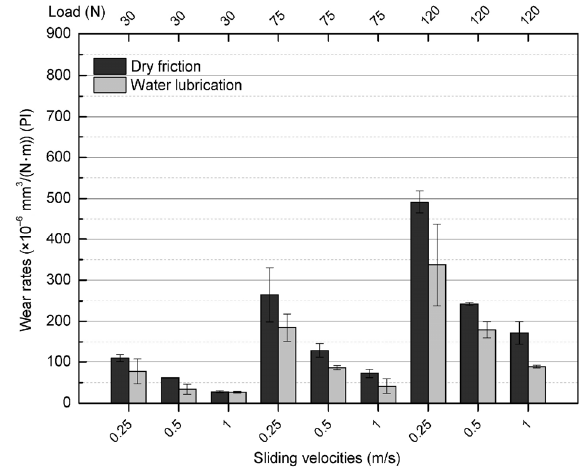
Fig. 7 The wear rates of PEEK at dry-friction and water-lubricated conditions under different applied loads and sliding velocities.